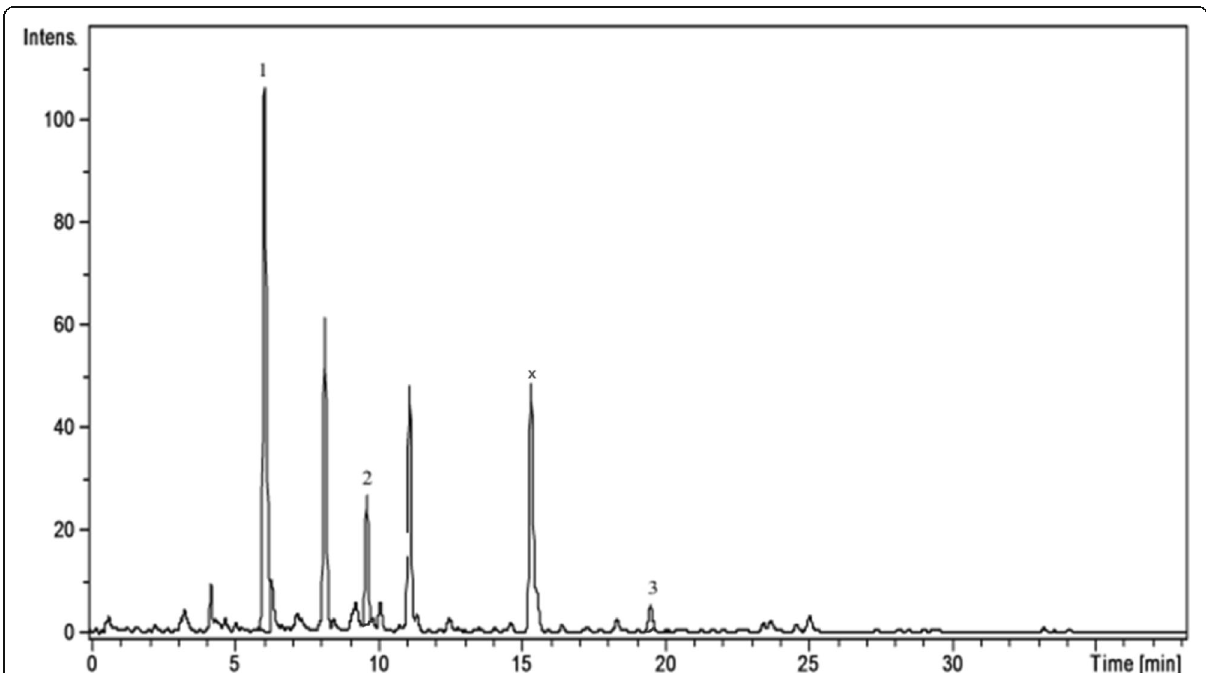
Fig. 4 HPLC chromatograms of L. vernum extract. Notes : The identified compounds: 1-chlorogenic acid; 2- p -coumaric; 3-isoquercitrin